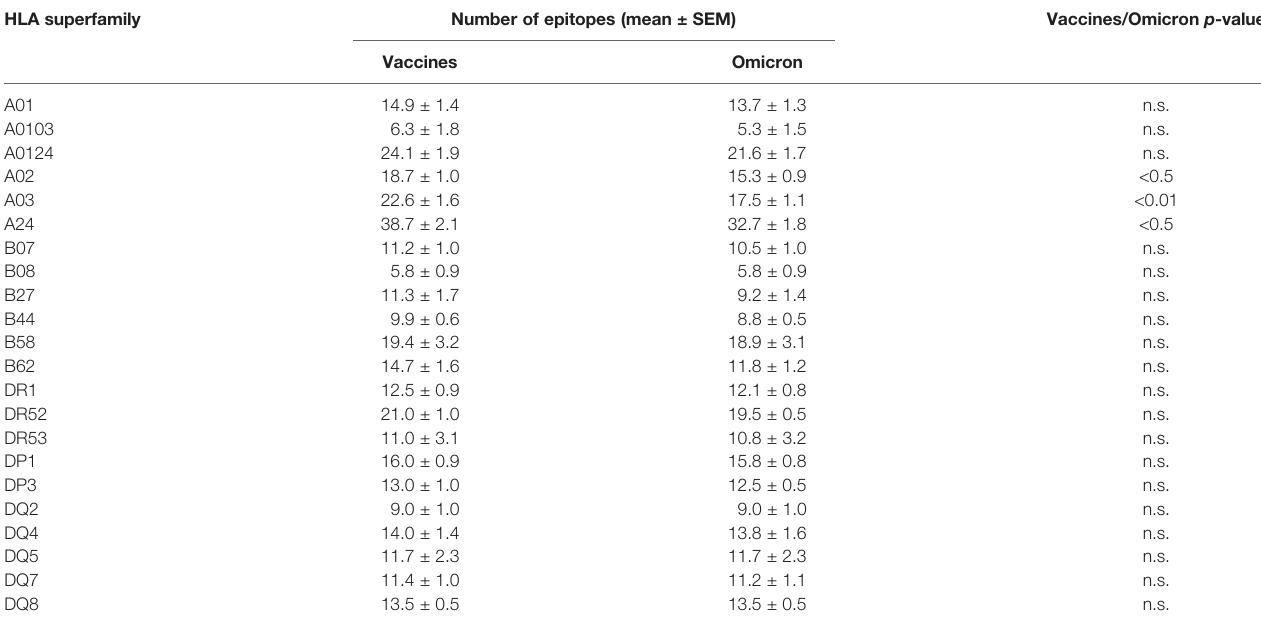
TABLE 1 | Summary of average number of epitopes in the Wuhan-1 and Omicron spike protein sequences predicted for HLA class I and II alleles including in the 12 and 10 HLA class I or class II supertypes, resepctively. HLA